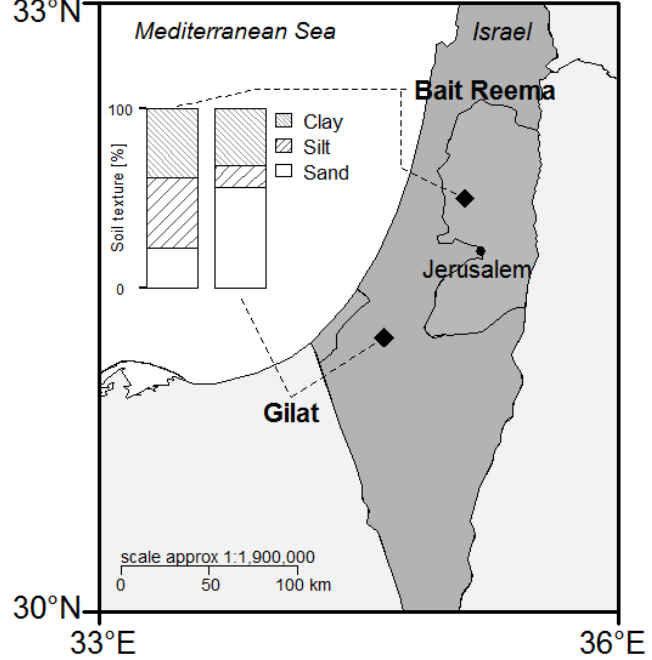
Figure 1. Map of Israel and the Palestinian Authority, asterisks indicate the two sampling sites Bait Reema and Gilat. Bars show the soil texture of both sites. Distance between the sites is approximately 100